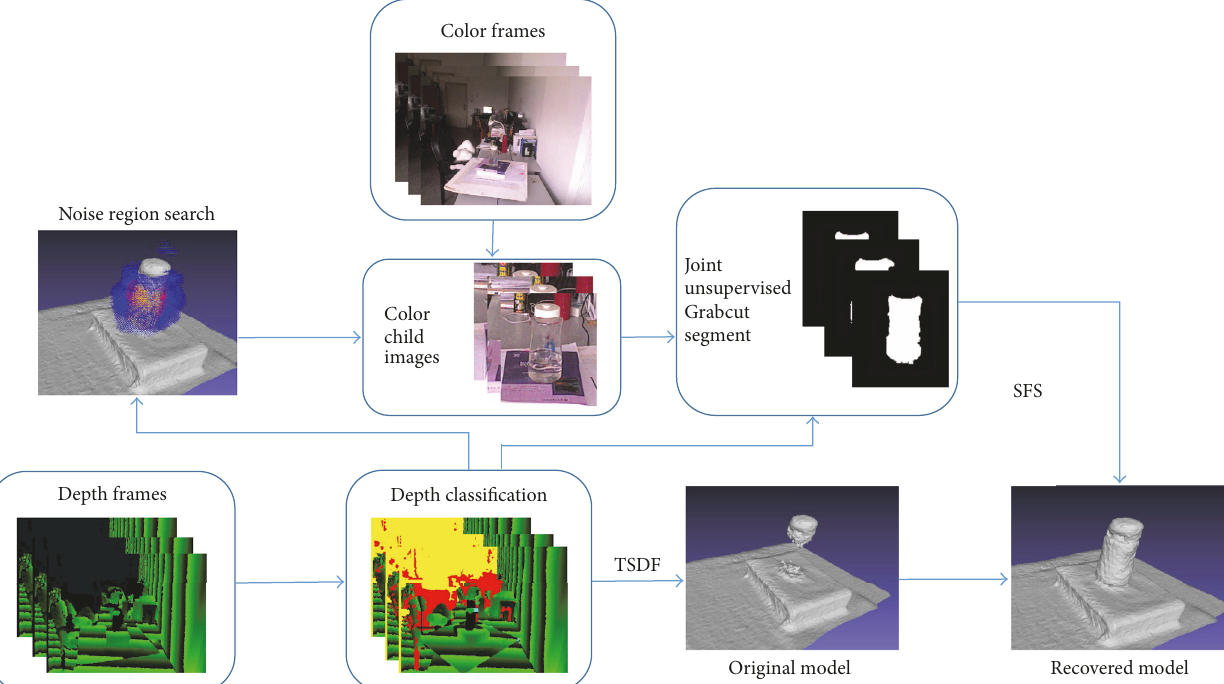
Figure 1: System overview; TSDF: truncated signed distance function; SFS: shape from